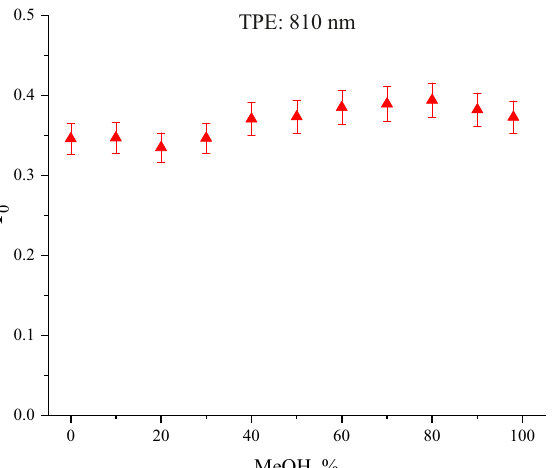
( 2 ) in Radachlorin in aqueous solutions of MeOH as a 0